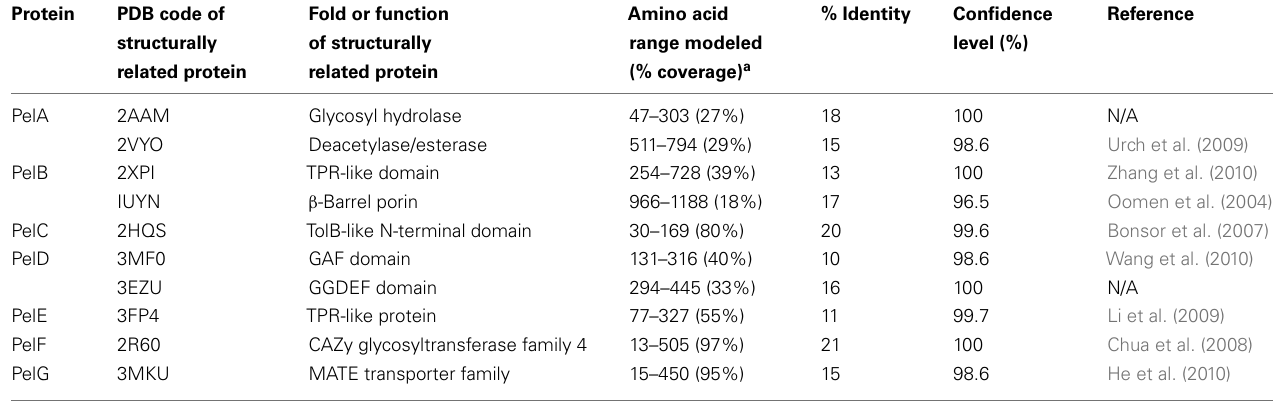
Table 2 | Structural predictions of Pel biosynthetic